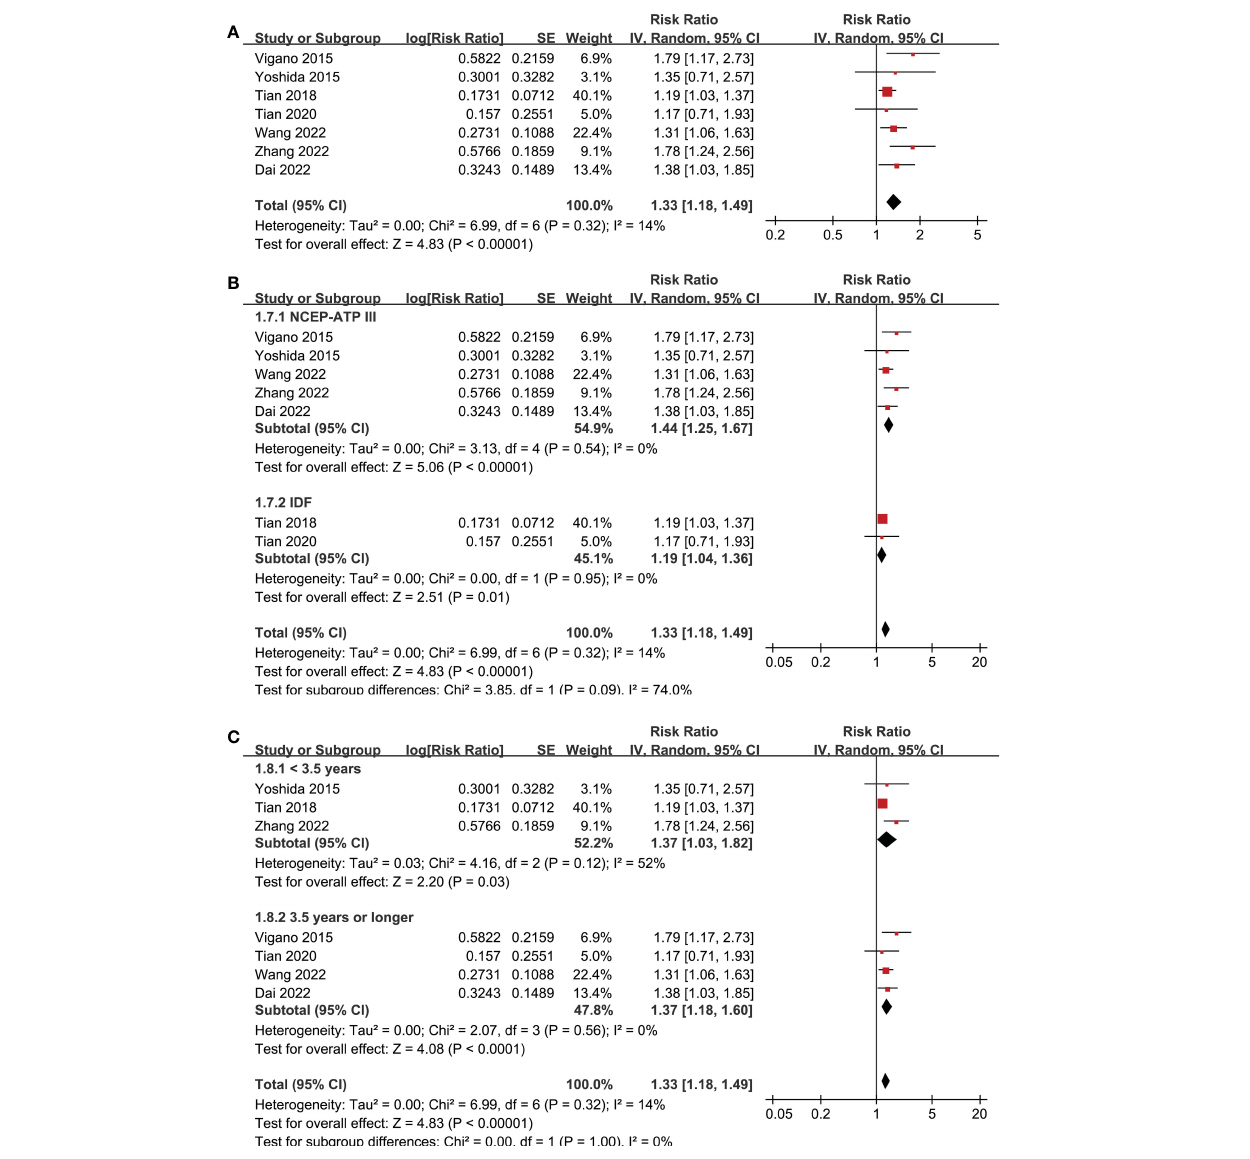
FIGURE 4 Forest plots for the meta-analyses regarding the association between MetS and PFS in patients with HCC. (A) overall meta-analysis; (B) subgroup analysis according to the diagnostic criteria for MetS; and (C) subgroup analysis according to the follow-up